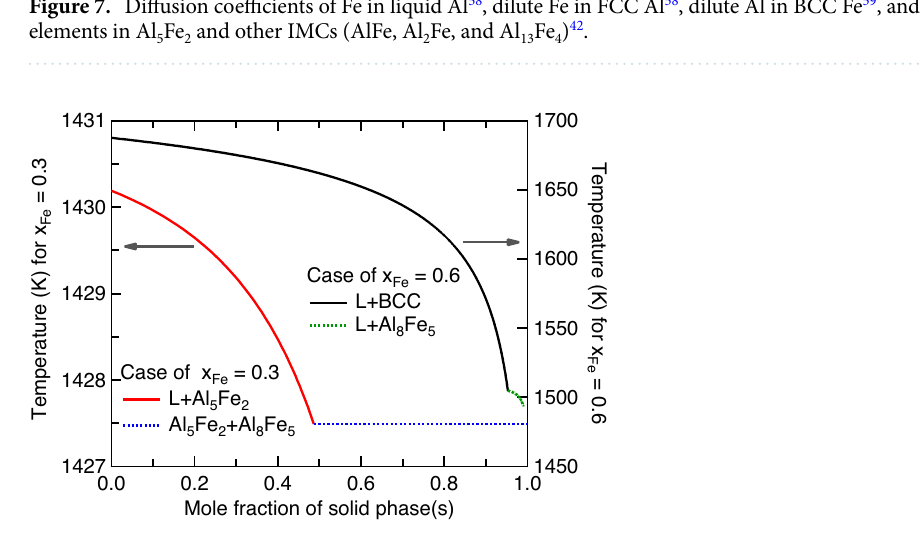
Figure 8. Calculated mole fractions of solid phases with x Fe = 0.3 and 0.6 based on Scheil simulations using the thermodynamic description modelled by Sundman et al. 9